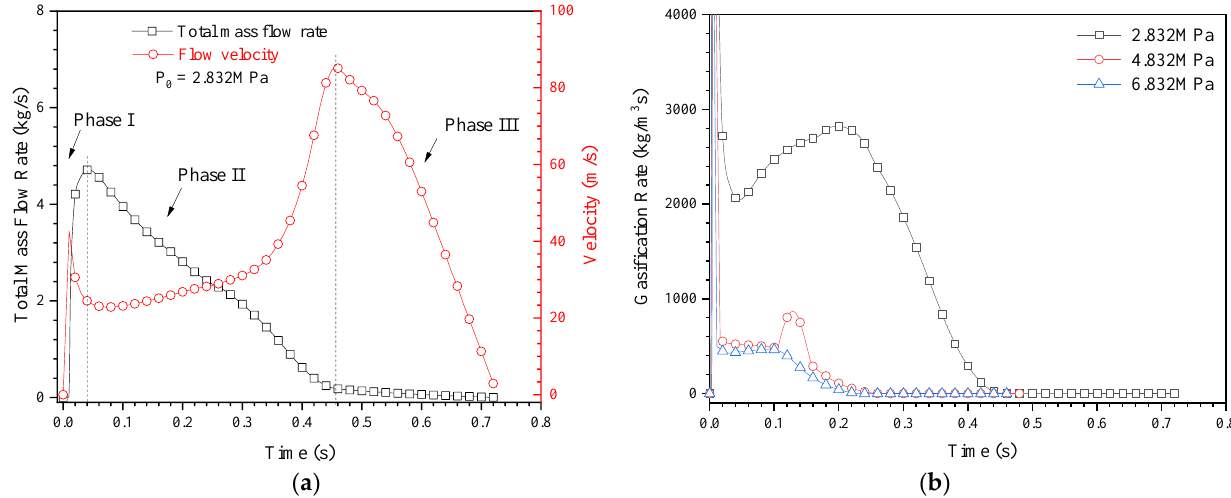
Figure 11. Diagram of flow velocity and gasification rate: ( a ) comparison of flow velocity with total mass flow rate; ( b ) variations of gasification rate under different filling pressures.